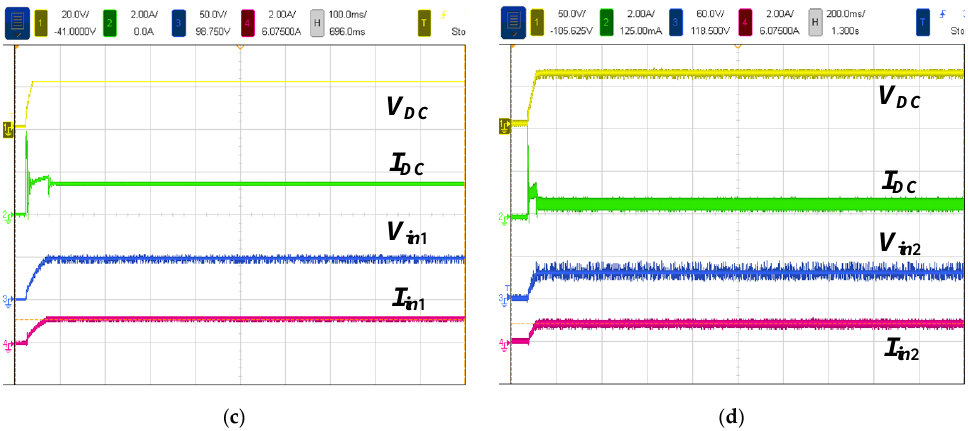
Figure 13. Experimental results of ( a ) The discharging scenario, case I; ( b ) The discharging scenario, Case II; ( c ) The charging scenario A; ( d ) The charging scenario B.